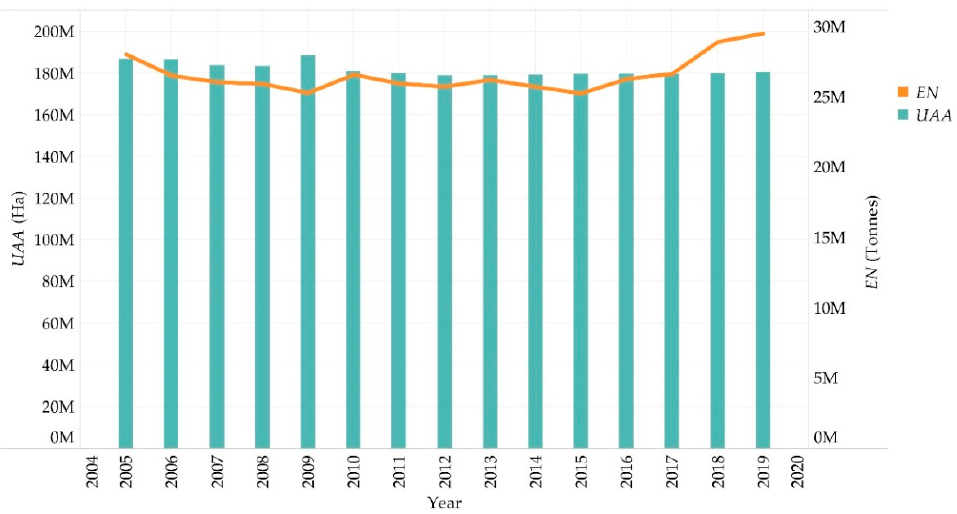
Figure 4. Total Used Agricultural Area ( UAA ) and Energy consumption in agriculture ( EN) for the period 2005–2019.